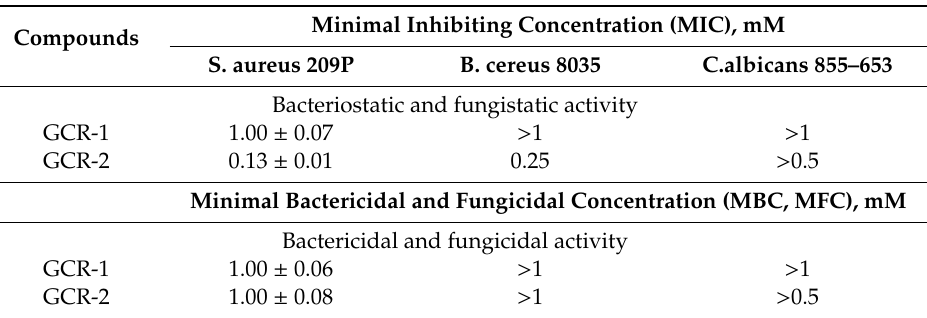
Table 2. Antimicrobial activity of GCR-1 and